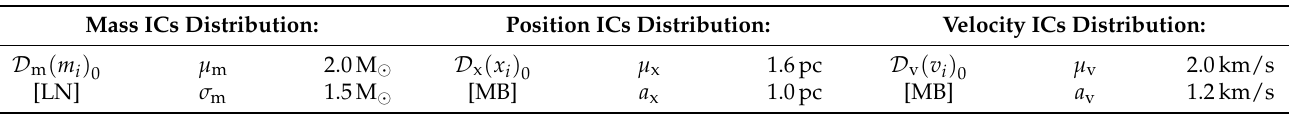
Table 1. Mass, position and velocity IC distribution parameters. Distributions plots are shown in Figures 2a, 3a and 6a. A specific realisation of such distributions is shown in Figures 2b, 3b and 6b. Mass ICs